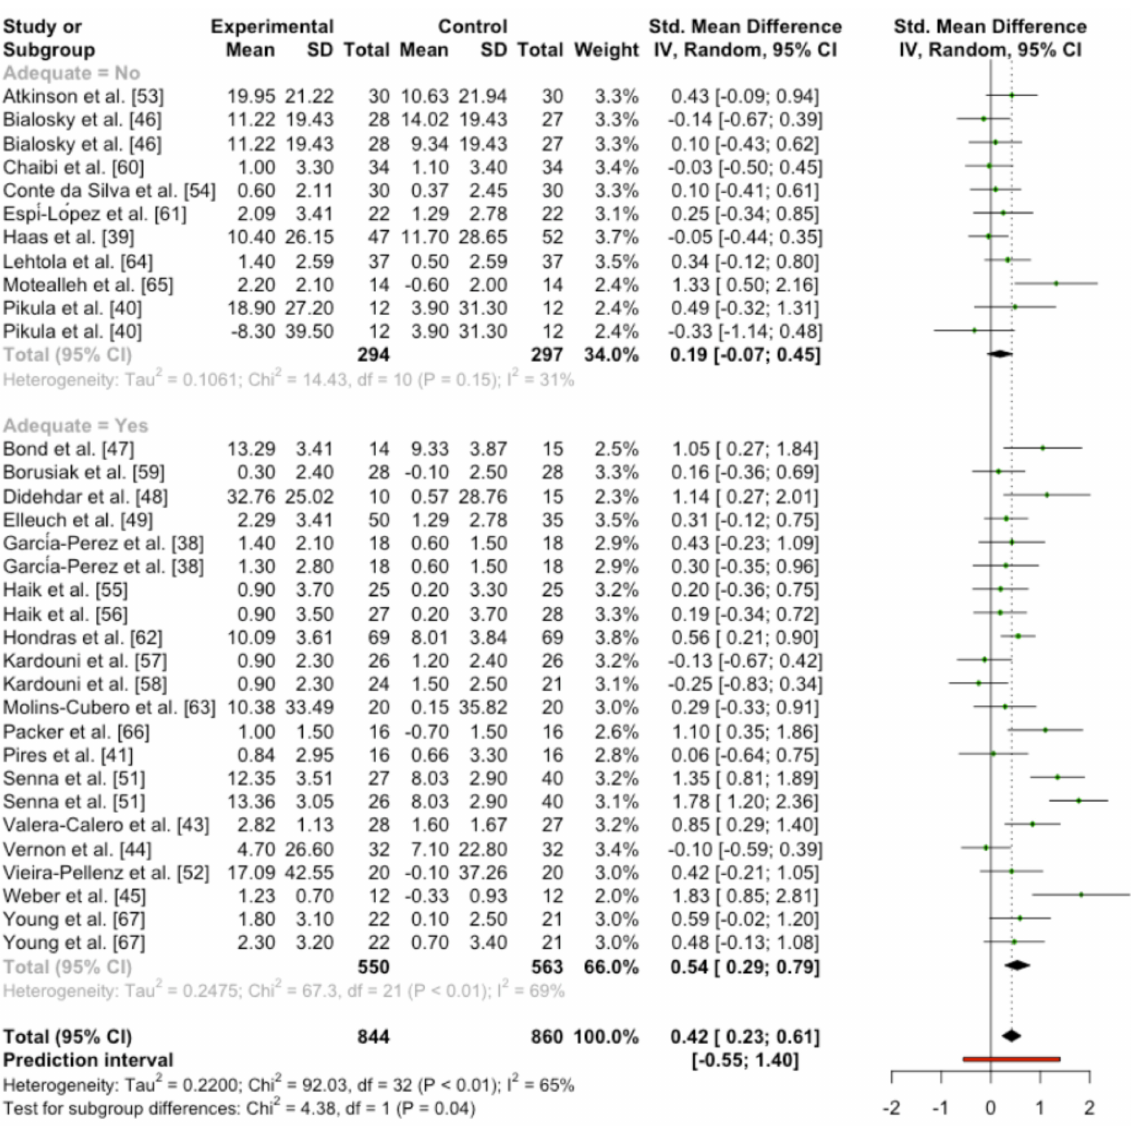
Figure 2. Risk of Bias Subgroup Analysis of manipulation trials. Positive values = In favor of intervention/Negative values = In favor of sham intervention. Standard Deviation (SD); Standard (std); Inverse Variance (IV); Confidence Interval